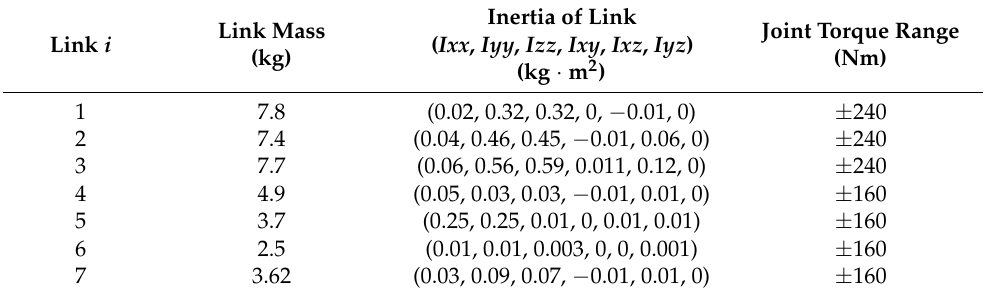
Table 2. Dynamic parameters for each